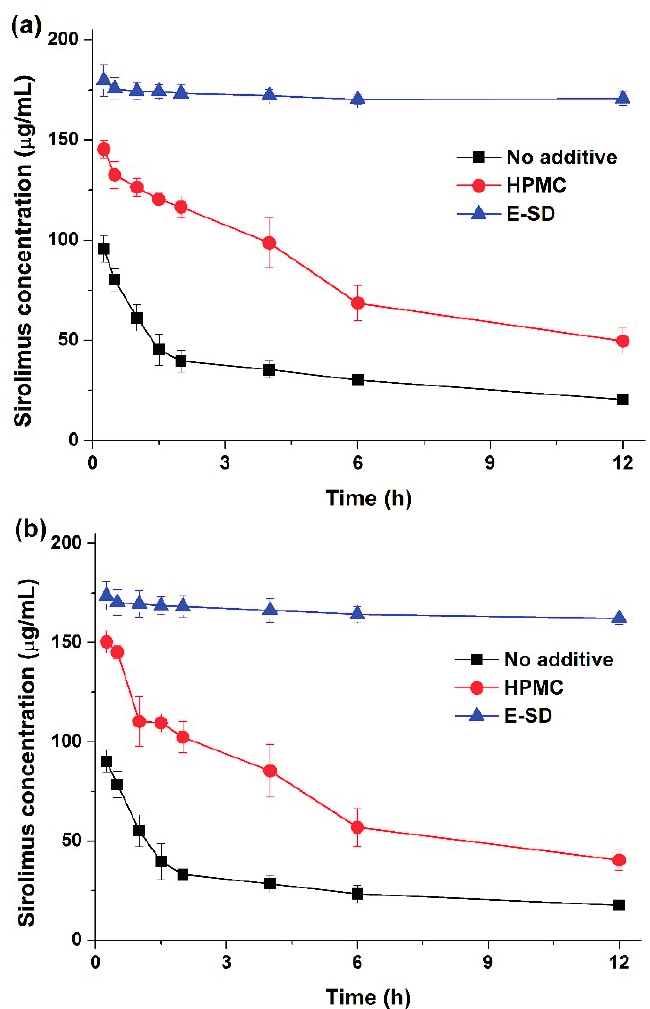
Figure 5. Effect of E-SD and HPMC on the recrystallization of sirolimus in two different media. Water ( a ) intestinal fluid (pH 6.8) ( b ). Data are expressed as the mean ± standard deviation ( n =